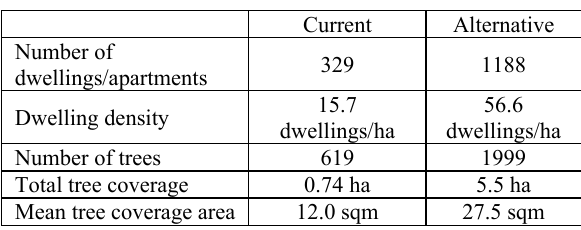
Table 1: Density and tree coverage information of the Current Model and the Alternative